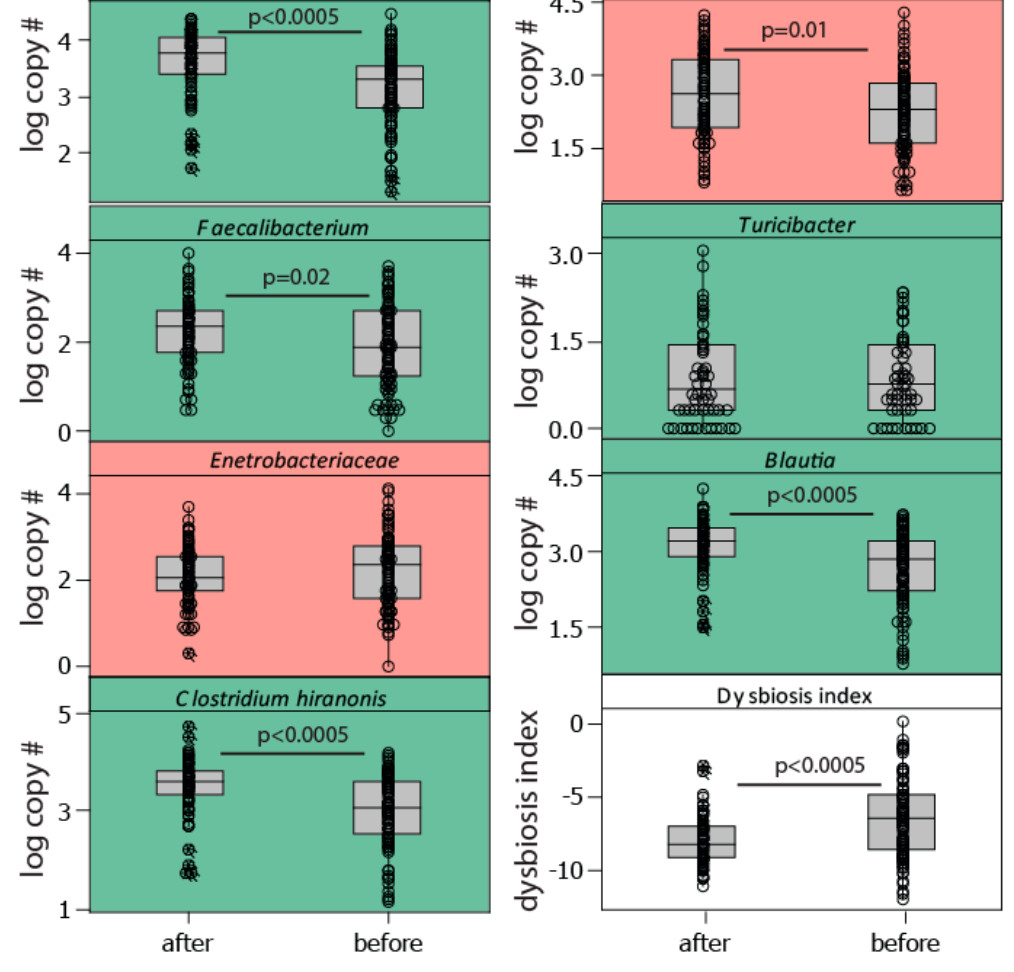
Figure 3. Bacterial taxa included in the dysbiosis index. The dysbiosis index was calculated as the sum of the log10 copy number for bacteria positively associated with the dysbiosis index (marked in red), while subtracting those negatively associated (marked in green). The association with dysbiosis has previously been determined [6]. Abbreviations: after—after the race, before—before the race.